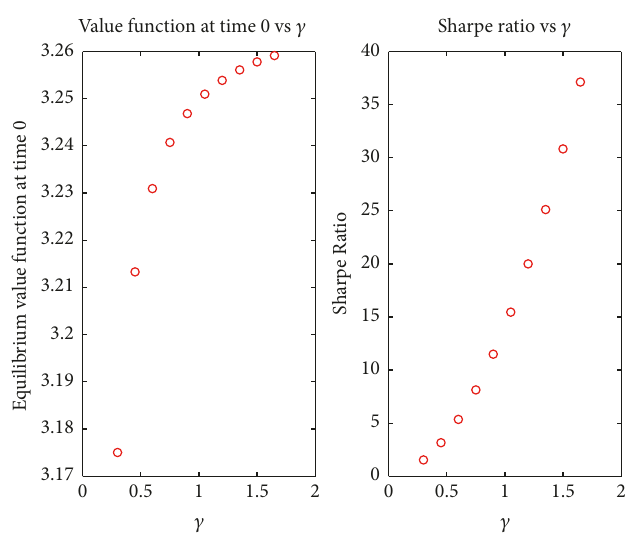
Figure 2: Value function and Sharpe ratio under different risk aversion coefficients.